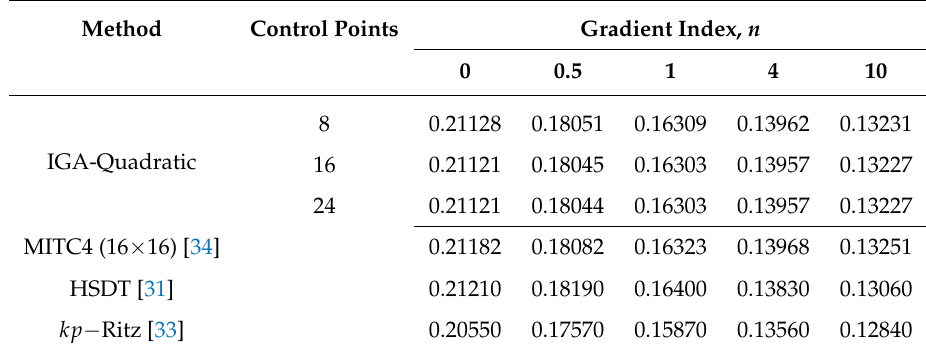
Table 4. Normalized first fundamental frequency parameter plate with a / h = 5 and simply supported along all the edges. Method Control